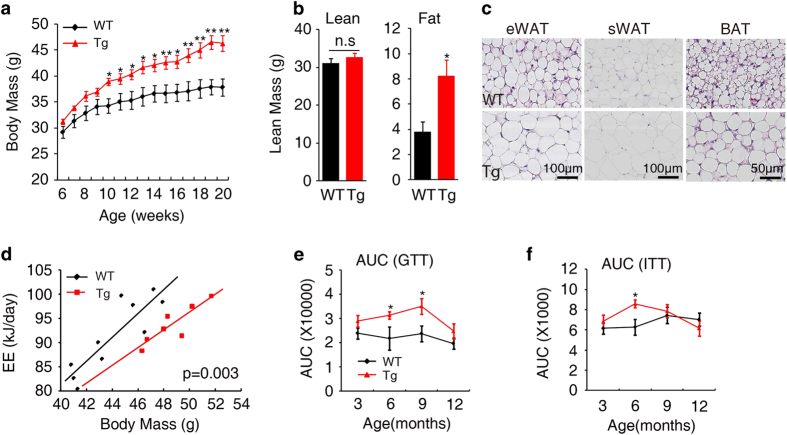
The DJ-1 transgene increases body mass gain and glucose intolerance. (a) Body mass cure of wild-type (WT) and DJ-1 transgenic mice (Tg, Line 13 CD-1 background) fed on a chow diet (WT, n=9; Tg, n=10). (b) Body lean and fat mass measured by MRI (WT, n=6; Tg, n=6). (c) HE staining of eWAT, sWAT and BAT from 6-month-old mice. (d) Statistical analysis by General Linear Model (GLM) and ANCOVA analysis of the DJ-1 Tg and WT mice energy expenditure (EE) (WT, n=10; Tg, n=7). (e) and (f) Quantification on the area under the curve (AUC) of GTT (e) and ITT (f) indicated age (n=6–12).